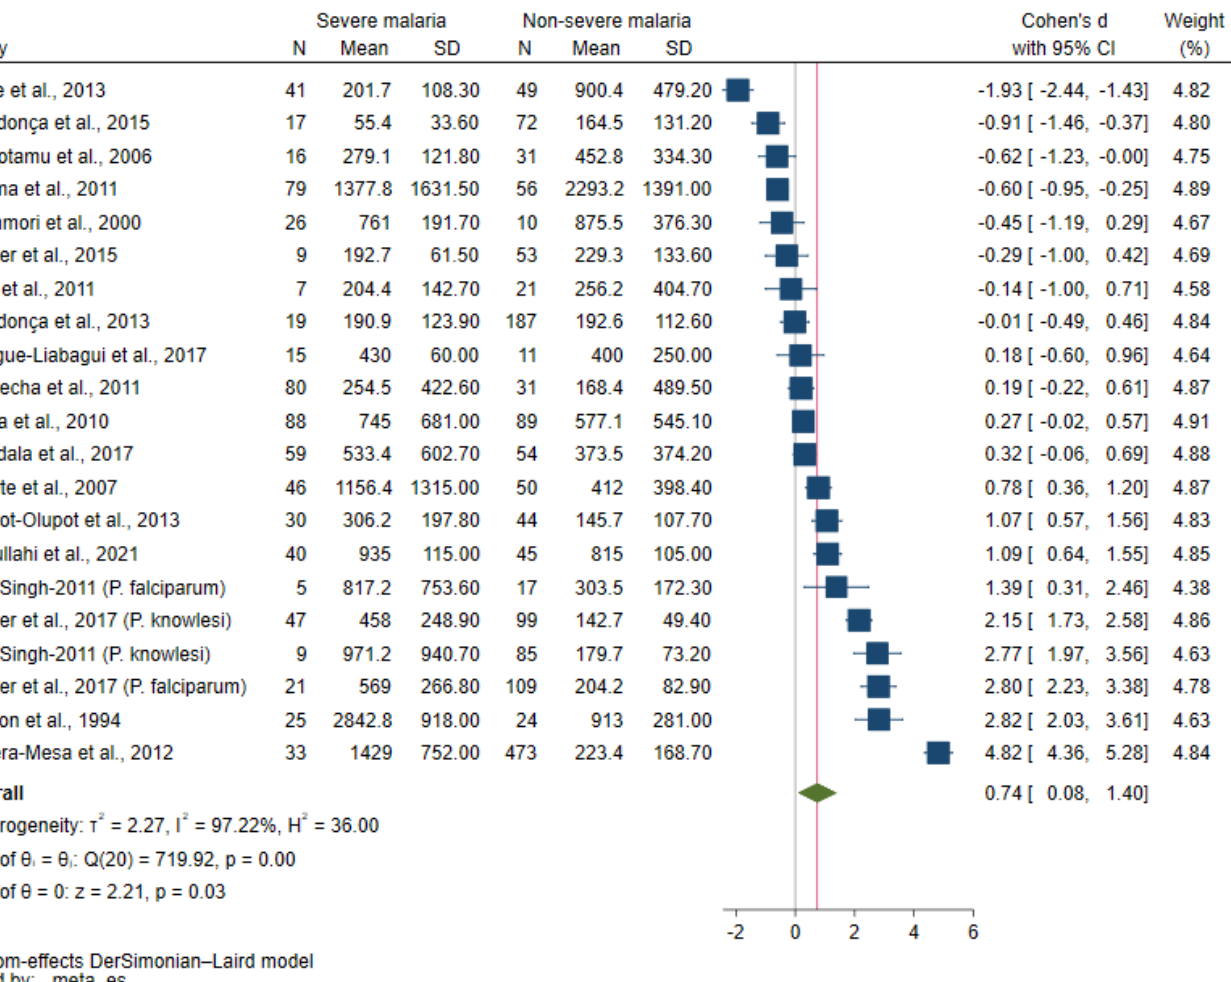
Figure 2. Forrest plot showing the difference in mean IL ‐ 10 levels between patients with severe and non ‐ severe malaria. Abbreviations : CI, confidence interval